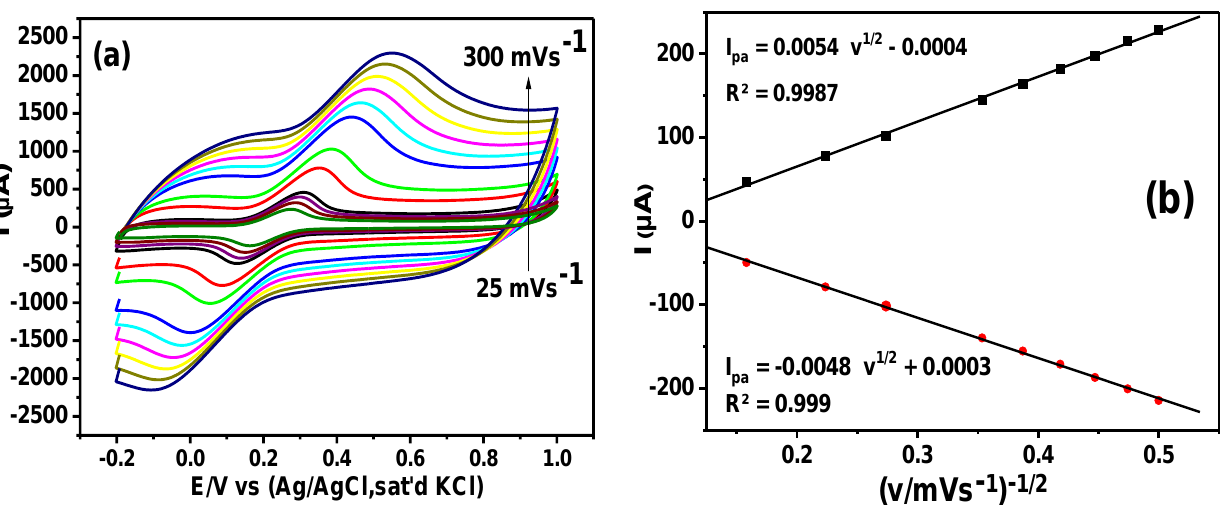
Figure 8. ( a ) Cyclic voltammograms of GCE-NiPcMWCNTs (scan rate, 25 – 300 mVs −1 ) and ( b ) the linear graph of the peak current versus square root of scan rate in 5 mM [Fe(CN) 6 ] 3 − /4 − solution prepared in 0.1 M PBS.